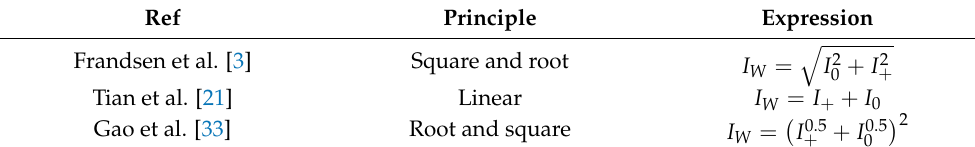
Table 4. Summation of superposition approaches for added turbulence intensity.